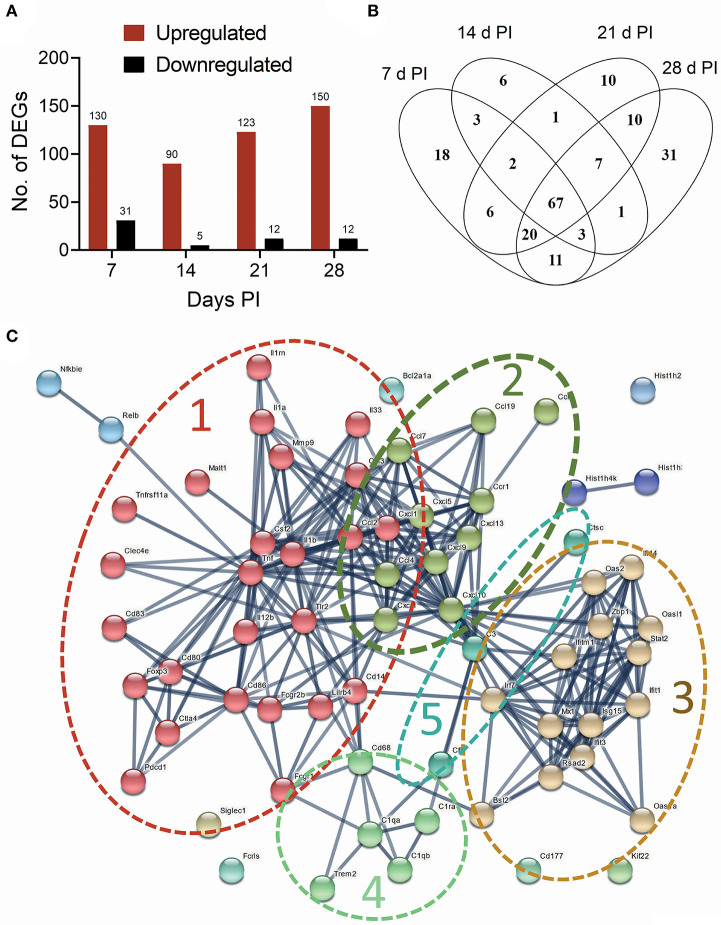
Instillation with 2.5 mg cSiO2 induces broad array of genes associated with autoimmunity in the lung after 7, 14, 21, and 28 d. (A) nCounter raw data from time course study were subjected to nSolver analysis, and differential gene expression was expressed as log2 ratio. Differentially Expressed Genes (DEGs) in lung tissue of mice exposed to cSiO2 with respect to Veh-treated controls were selected if they passed the threshold cutoff of log2 ratio by 0.58 (≥1.5 FC) for upregulated genes (red bar), and −0.58 (≤1.5 FC) for downregulated genes (black bar). (B) Venn diagram illustrating the number of upregulated genes that were shared at 7, 14, 21, and 28 d PI. A total of 67 upregulated genes were differentially expressed at all the time points with respect to Veh control. (C) Protein-protein interaction network of commonly upregulated DEGs expressed at all time points created using STRING. The interactions were visualized with a high confidence >0.7. Proteins were clustered using the MCL algorithm. As indicated by dashed lines, several large clusters were identified: cluster 1, proinflammatory genes (red nodes); cluster 2, chemokines (olive nodes); cluster 3, interferon-related genes (tan nodes); clusters 4 and 5, complement (light green and blue nodes, respectively).